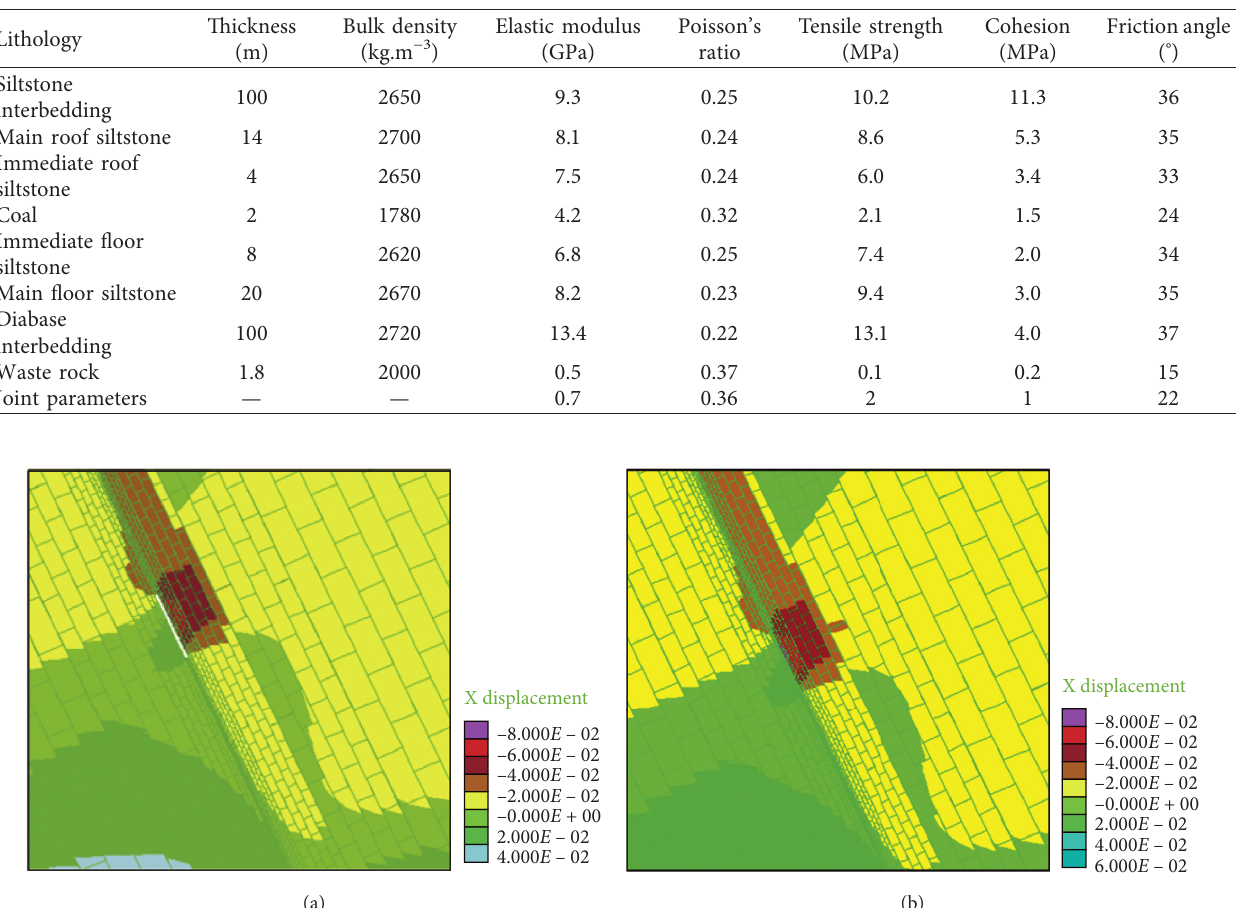
Table 1: Mechanical properties of rock parameters of the numerical model.